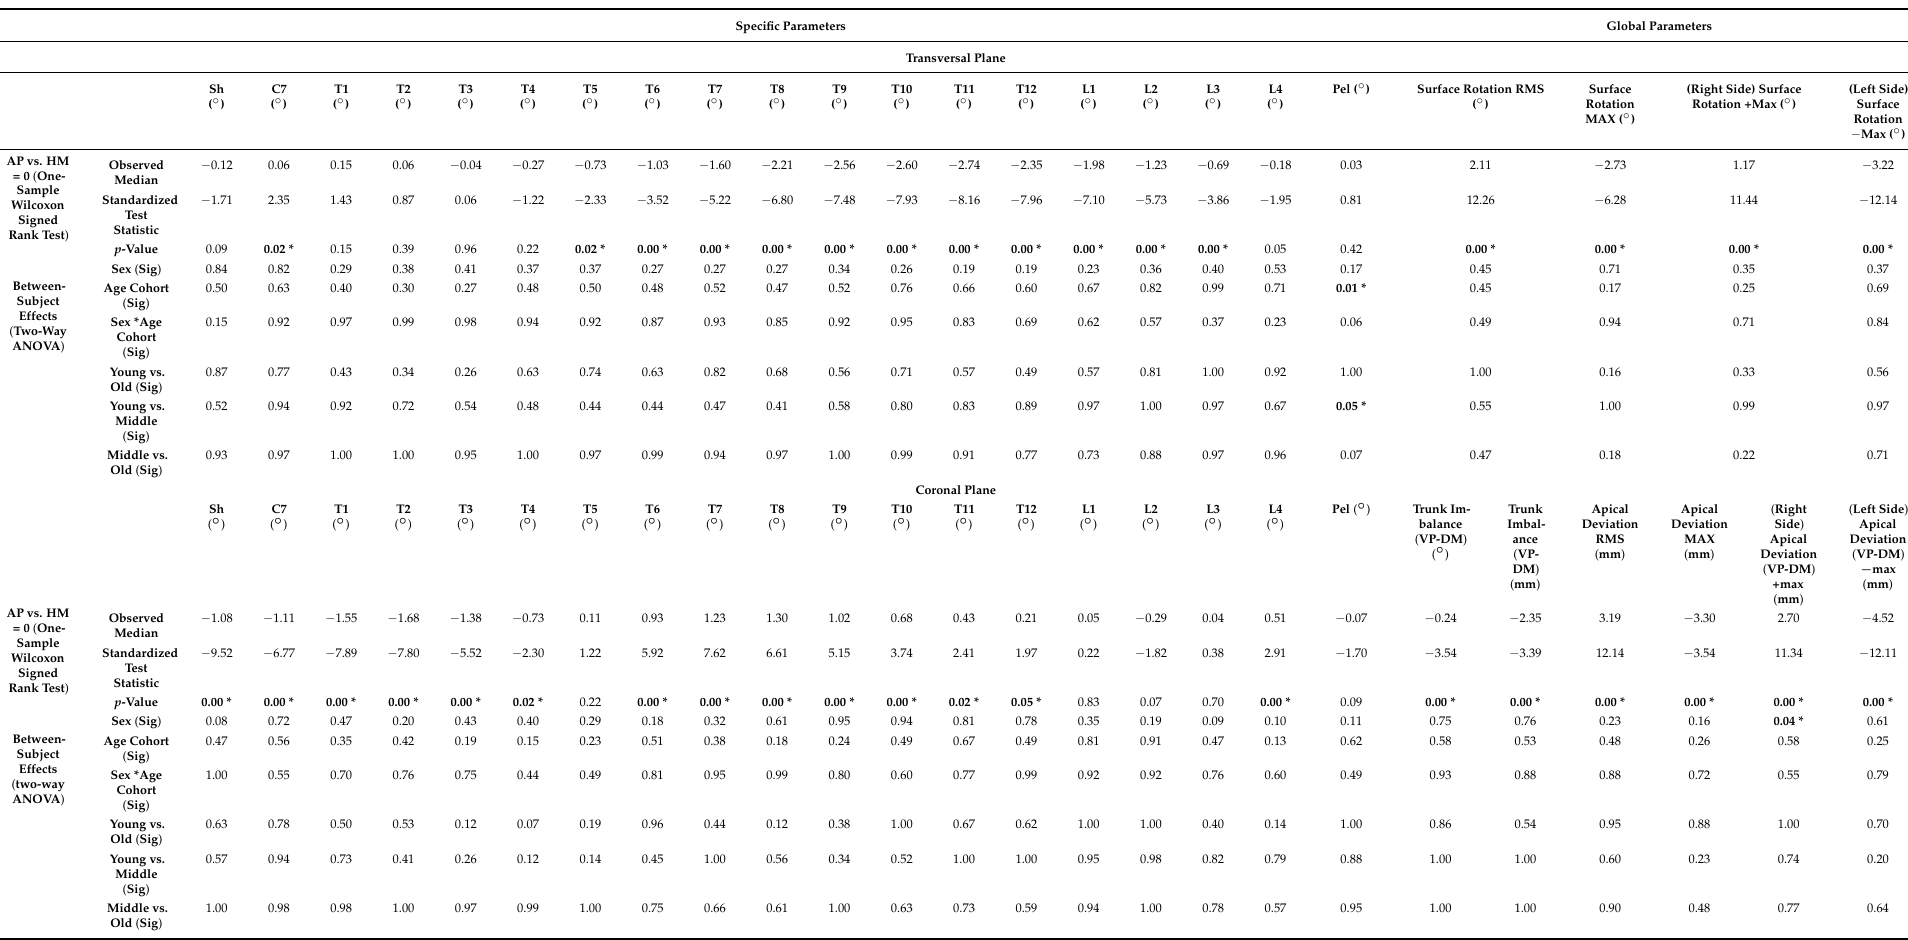
Table 5. Results of the explorative statistical analyses (one-sample Wilcoxon signed rank test and two-way analyses of variance) of the spinal parameters in all three planes of